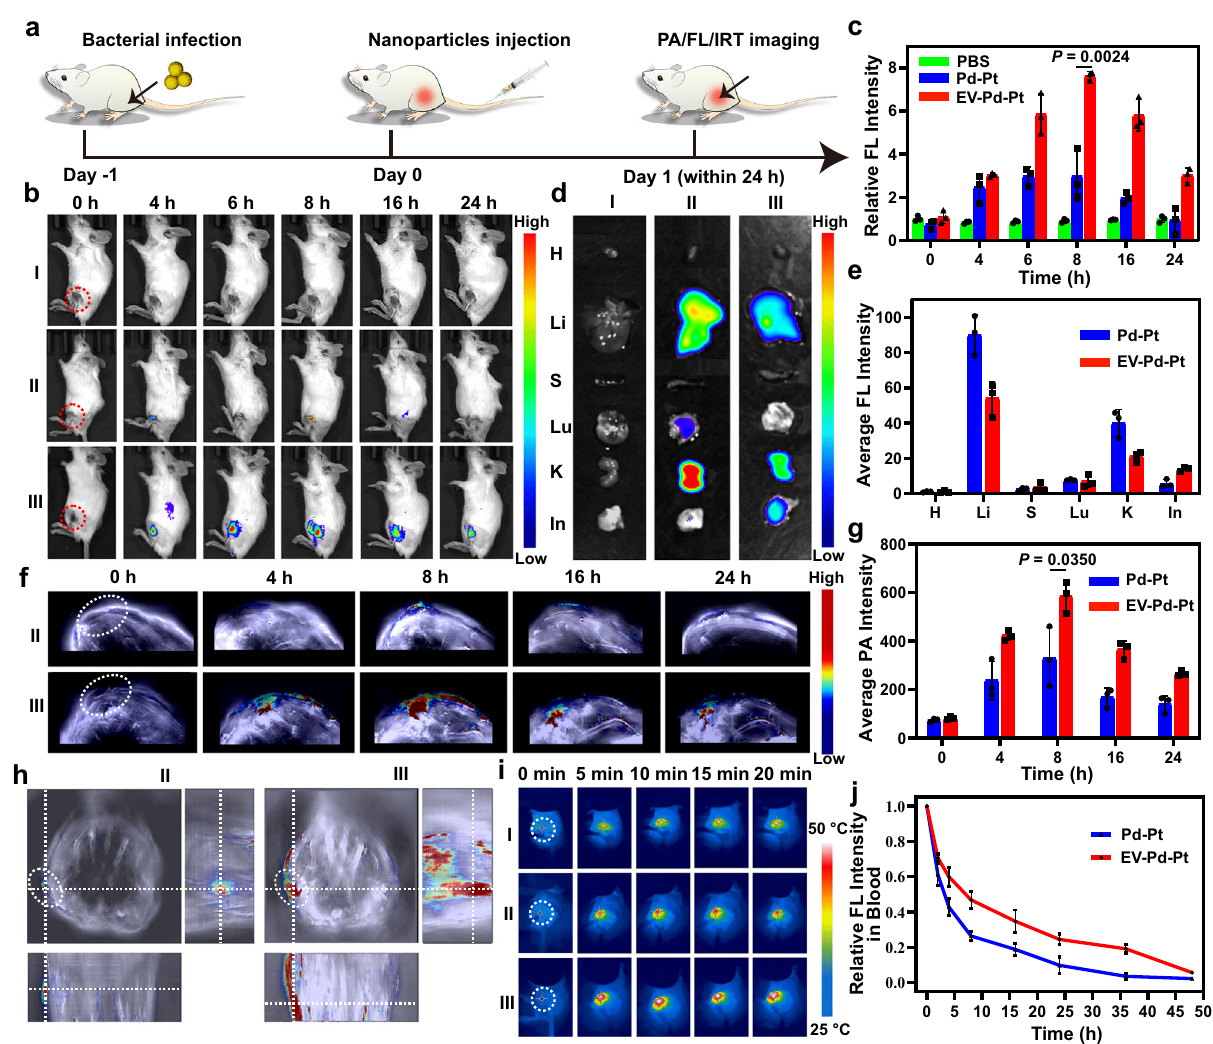
Fig. 7 | In Vivo imaging and biodistribution of EV-Pd-Pt nanoparticles. a Schematic illustration of the S. aureus infection model establishment for FL, PA, and IRT imaging. b In vivo time-dependent FL images of S. aureus -infected mice after the intravenous injection of PBS (I, control), Pd-Pt (II), and EV-Pd-Pt (III). c Quantitative analysis of S. aureus -infected thighs after different treatments. FL images ( d ) and average FL intensity ( e ) of major organs and the infected tissues afterdifferenttreatmentsat8hpost-injection.H,Li,S,Lu,K,andInrepresentheart, liver, spleen, lung, kidney, and infected tissue, respectively. PA images ( f ) and intensity ( g ) of S. aureus -infected thighs of mice after the intravenous injection of